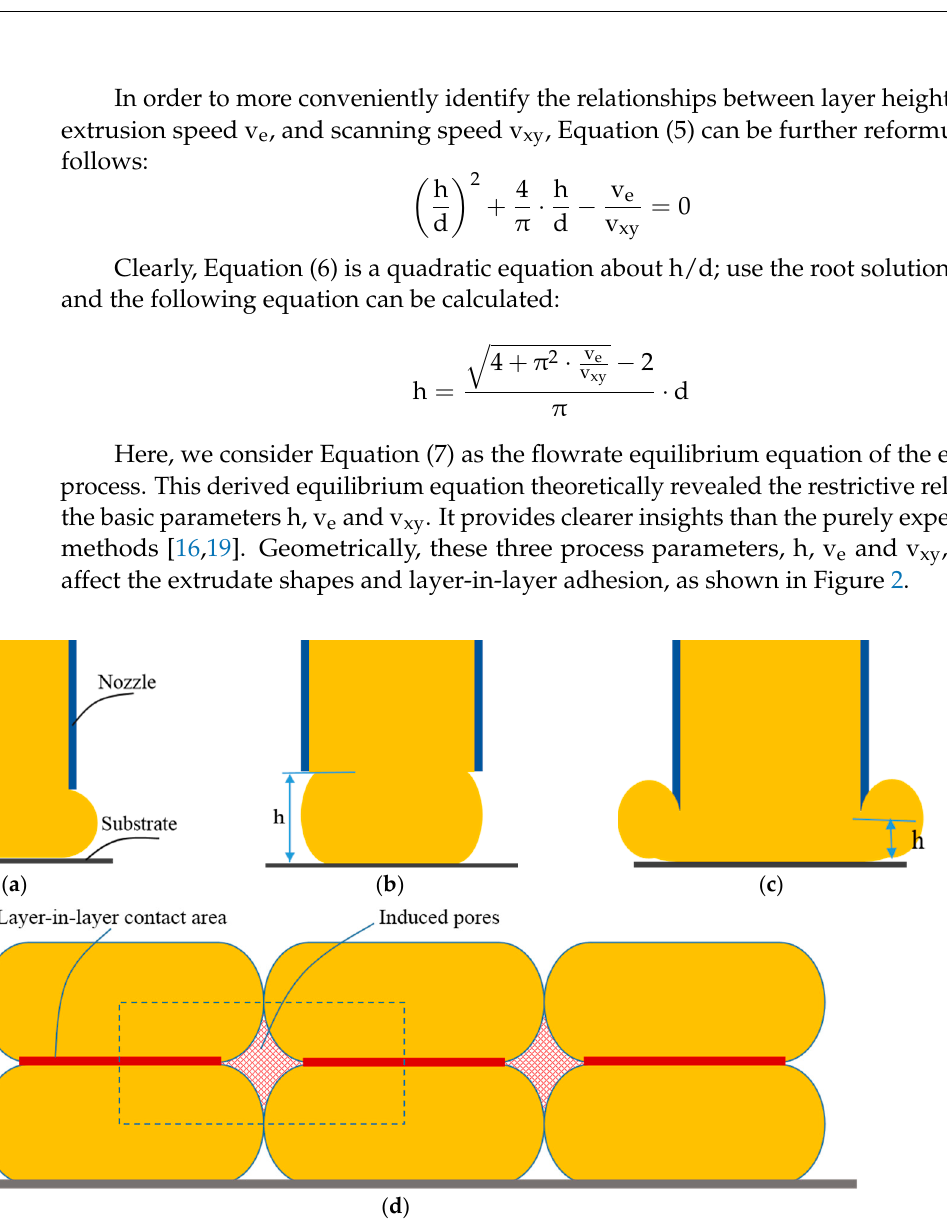
Figure 2. Geometries of the extrudate shapes and layer-in-layer adhesion: ( a ) If the layer height is suitable, then it has a high layer-in-layer contact and a small layer-in-layer gap. ( b ) If the layer height is too big, then it has a low layer-in-layer contact and big layer-in-layer gap. ( c ) If the layer height is too small, then it has an irregular extrudate shape and big size error. ( d ) The ideal layer-in-layer contact area and the induced